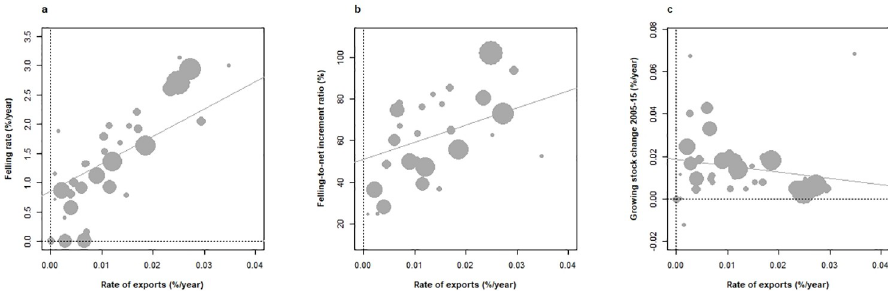
Fig 6. Relationships between the annual rates of wood exports and (a) felling rate, (b) felling-to-net increment ratio and (c) changes in the growing stock over 2005–15 across European countries under study. Both exports, felling and GS changes expressed as fractions (%) of GS volume in 2005. Weighted correlations (forest area in 2015): (a) +0.65 (p < 10–5), (b) + 0.49 (p < 0.01), (c) –0.34 (p < 0.05).